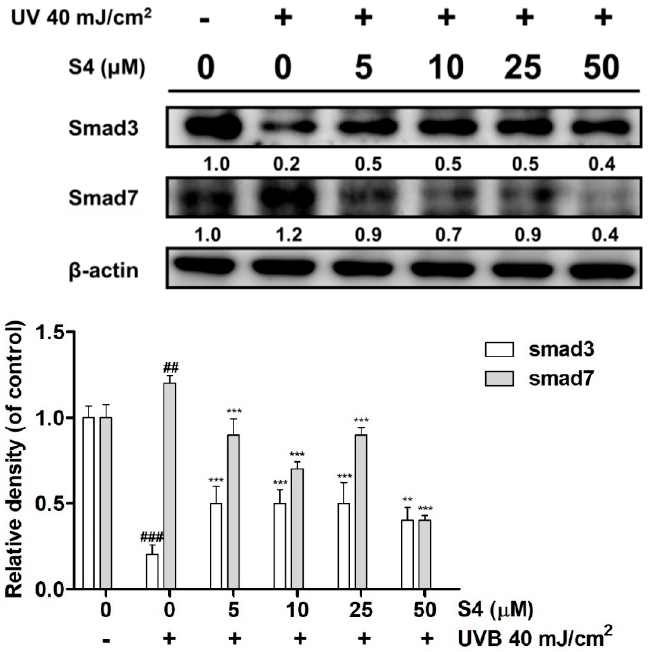
Figure 5. Effect of S4 on UVB-mediated Smad3 and Smad7 expression in human skin fibroblasts. The results were given as mean ± standard deviation (n = 3). Significant difference versus non-irradiation group: ##, p < 0.01; ###, p < 0.001. Significant difference versus non-treatment group: **, p < 0.01; ***, p < 0.001.